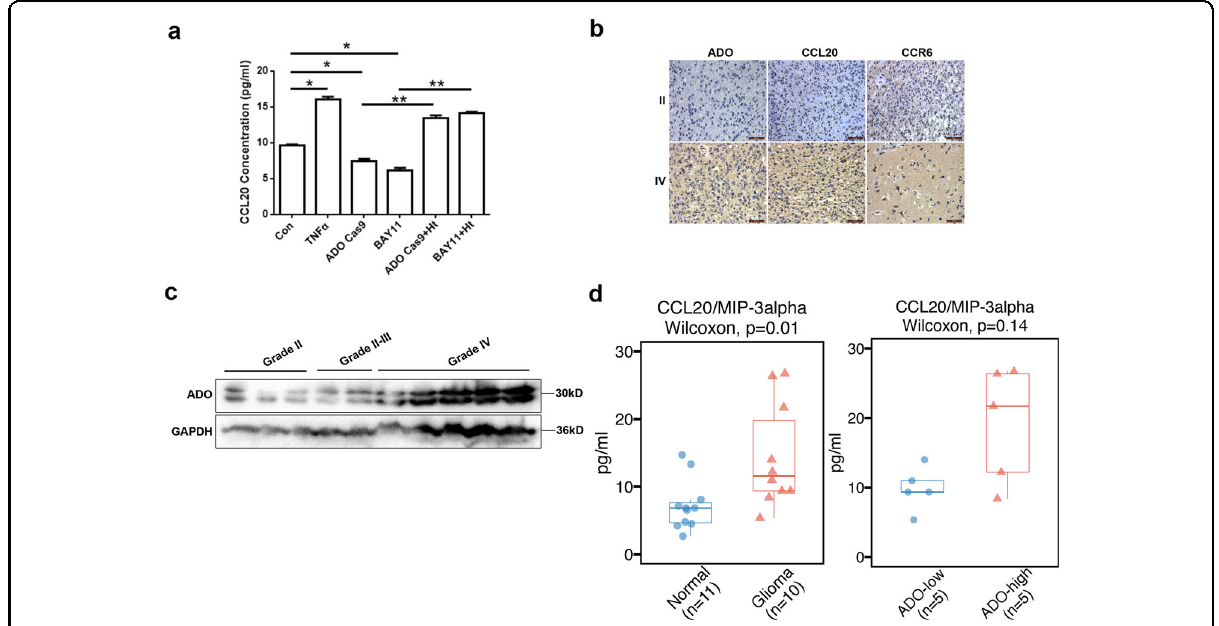
Fig. 5 ADO promotes glioma stemness via augmenting a NF- κ B-CCL20 feedforward activation loop. a The concentrations of CCL20 generated from 6 groups were detected using Elisa: LN229 control group, cells treated with TNF α (2 μ M), ADO-Cas9 cells, cells paired with NF- κ B inhibitor BAY11-7082 (2 μ M), ADO-Cas9 cells companied by hypotaurine (2 mM), BAY11-7082 companied by hypotaurine (2 mM). b Serial sections from patients were used to study ADO, CCL20, and CCR6 expression by immunohistochemistry. Scale bars = 50 μ m. Representative staining patterns are shown. c Western blot analysis of ADO expression in 10 glioma patients. Cerebrospinal fl uid was collected from these 10 glioma patients with varying ADO levels to test for intracranial CCL20, CXCL1, CXCL2, CXCL5, and CXCL16 levels using Luminex assays (R&D Systems). d The concentrations of CCL20 were compared between in glioma patients and nontumor patients, and also in patients with high and low levels of ADO. Data represent three independent experiments with similar results. Student ’ s t -test, * p < 0.05, ** p <